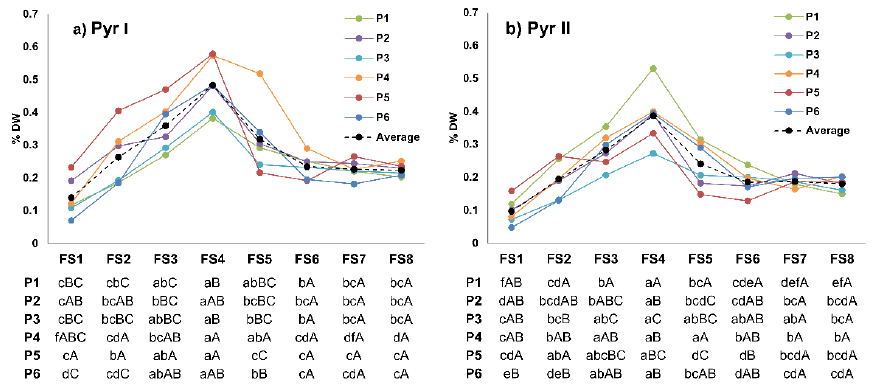
Figure 3. Content of ( a ) pyrethrin I and ( b ) pyrethrin II across the eight flower developmental stages in six Dalmatian pyrethrum populations. Lowercase letters refer to differences between phases in the same population, while uppercase letters refer to differences between populations within the same phase.